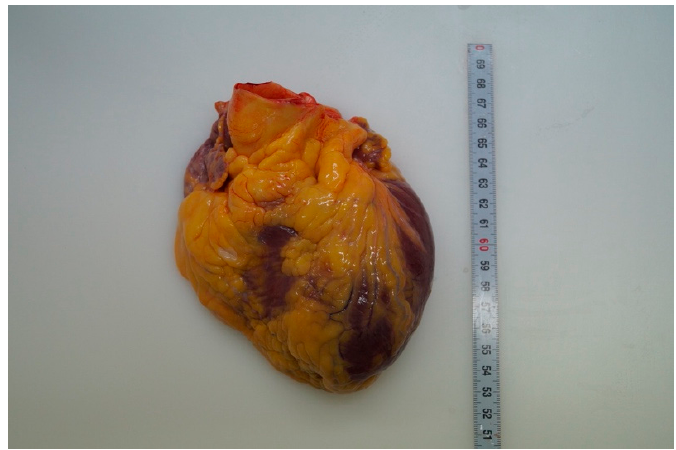
Figure 1. Macroscopic appearance of the